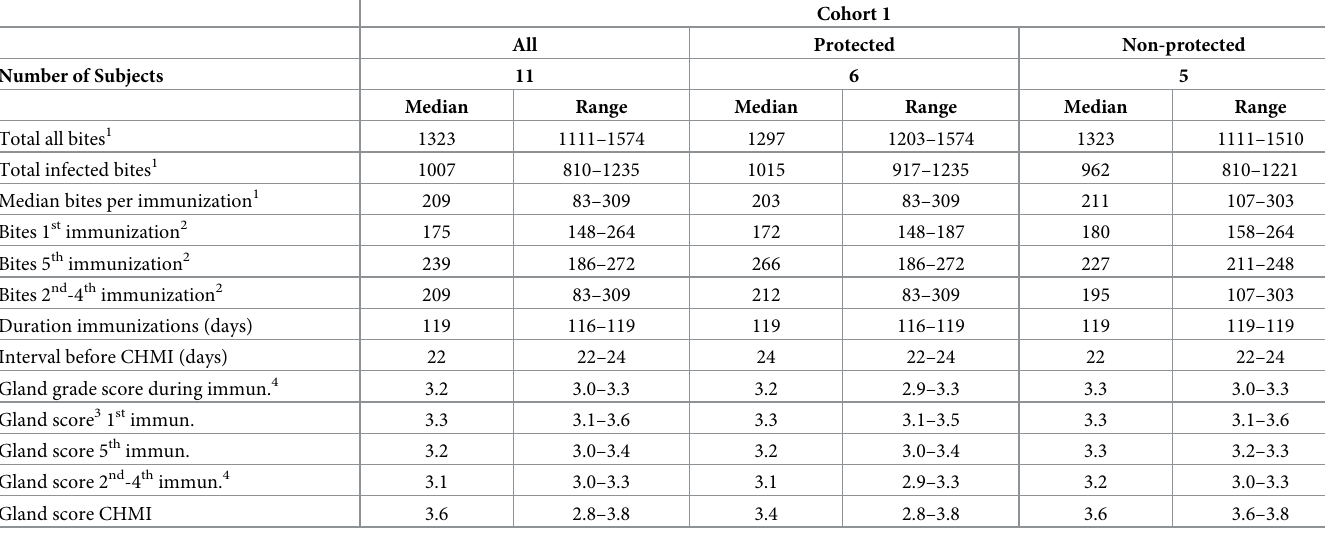
Table 4. Cohort 1—Summary of true-immunizations: Mosquito bites, gland scores and duration of immunizations. Cohort 1 All Protected